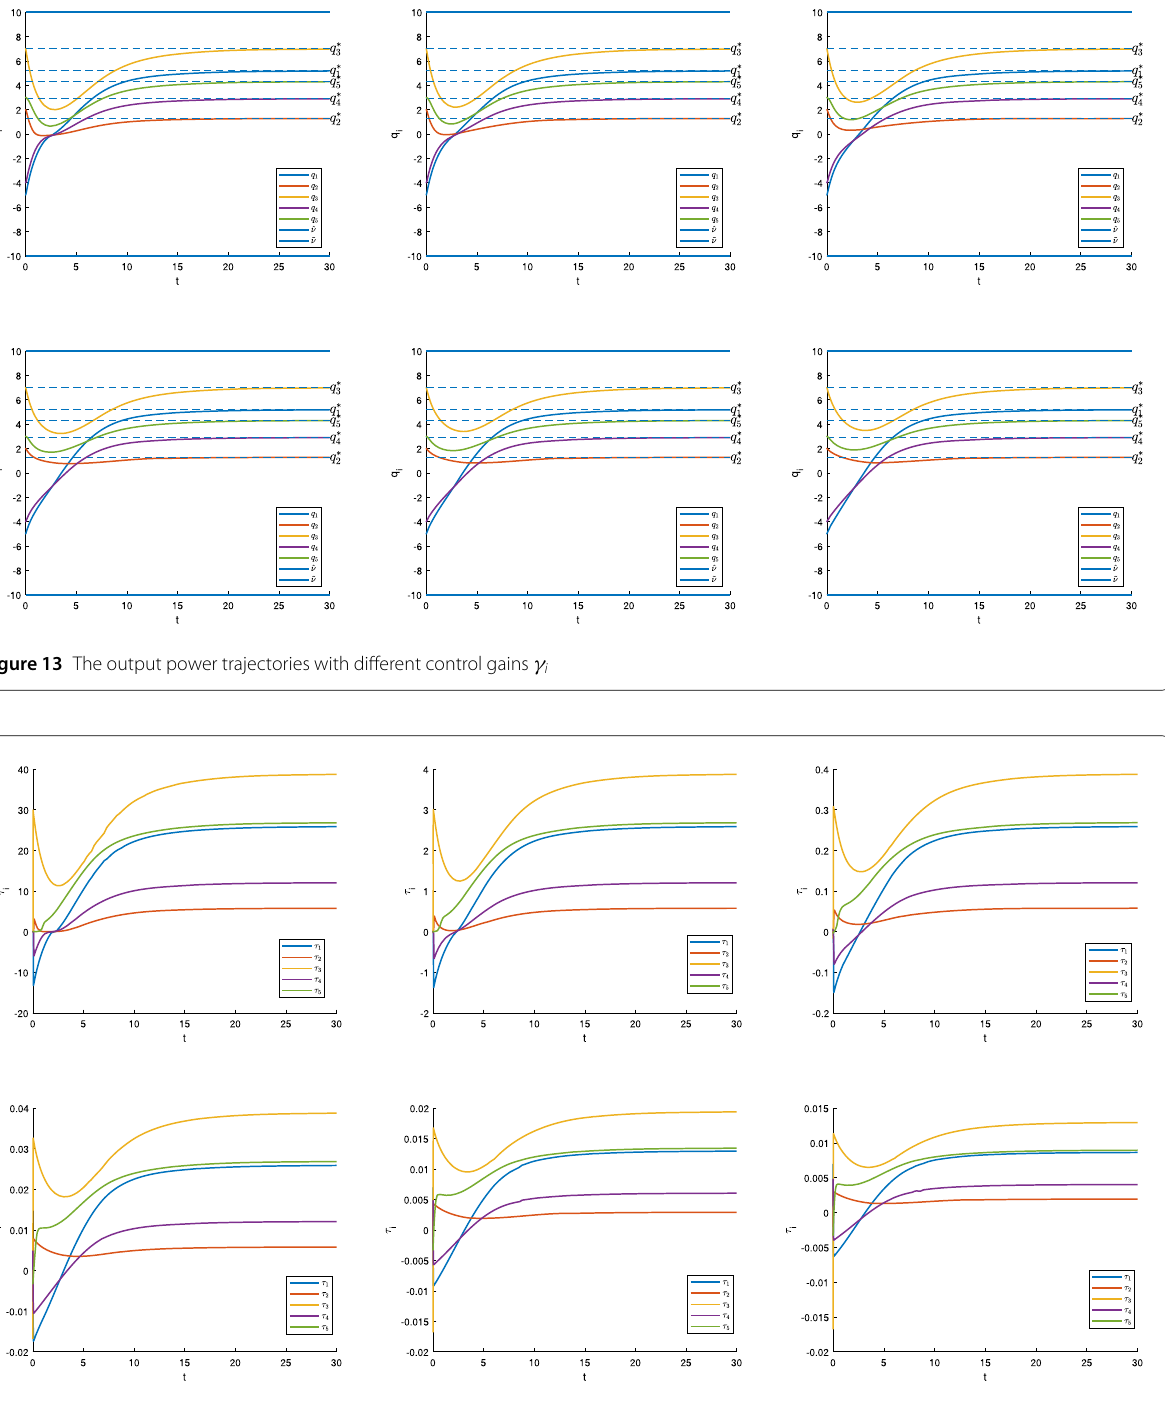
Figure 14 The control torques with different control gains γ i